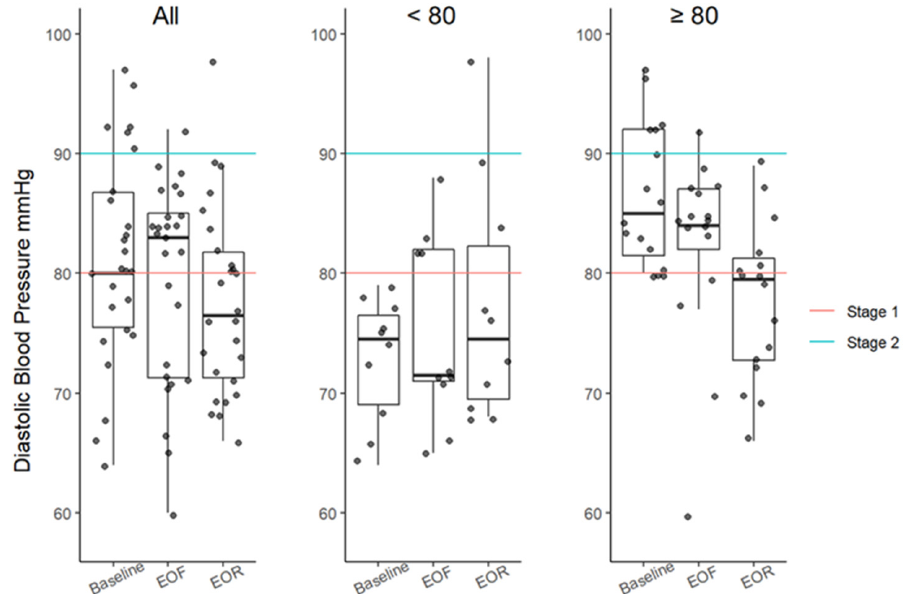
Figure 4. DBP boxplots at baseline, EOF, and EOR. Data further categorized based on high threshold ( ≥ 80 mmHg; red line). DBP between 80 and 89 mmHg is considered stage 1 hypertension. SBP ≥ 90 mmHg (blue line) is considered stage 2 hypertension. Boxplots represent the minimum value, first (lower) and third (upper) quartiles, the median, and the maximum value. EOF, end of fast; EOR, end of refeed; DBP, diastolic blood pressure; mmHg, millimeters of mercury.